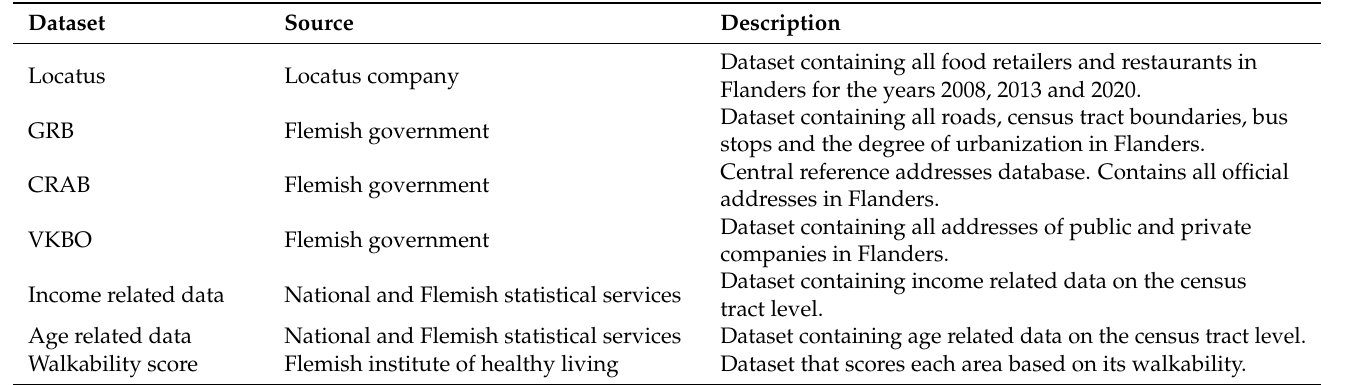
Table 1. The different datasets used in this